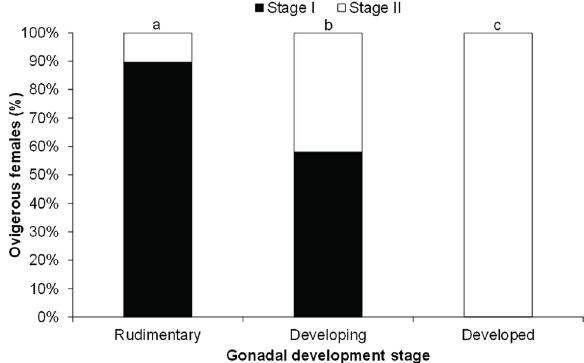
Figure 3. Nematopalaemon schmitti (Holthuis, 1950). Frequency of ovigerous females (N = 100) in each embryo development stage (I = initial, II = final) related to each gonadal development stage (Rudimentary, Developing,